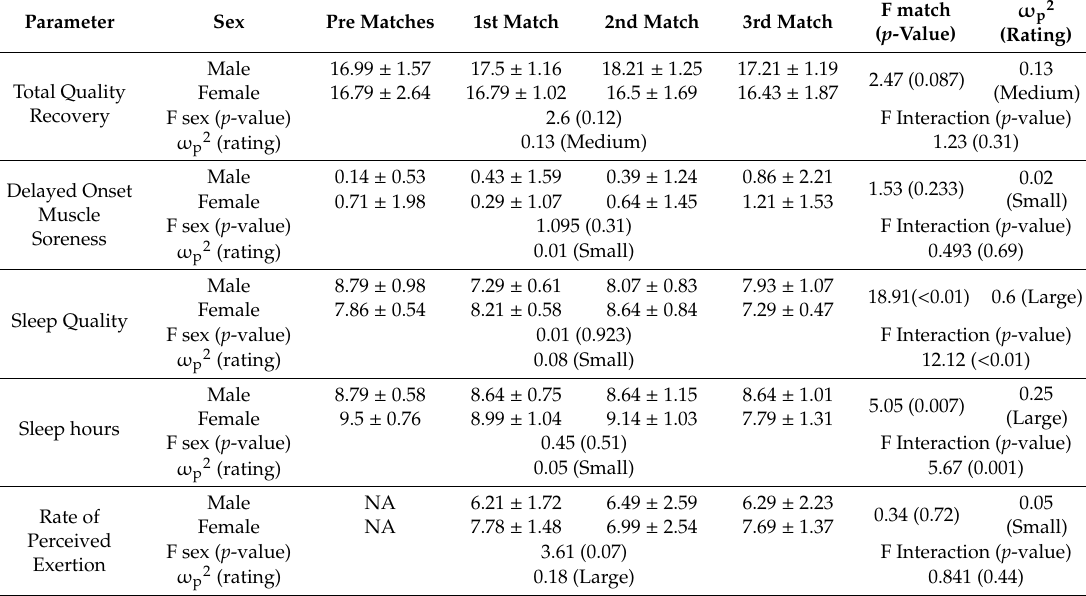
Table 2. Perceptual recovery comparison throughout matches by